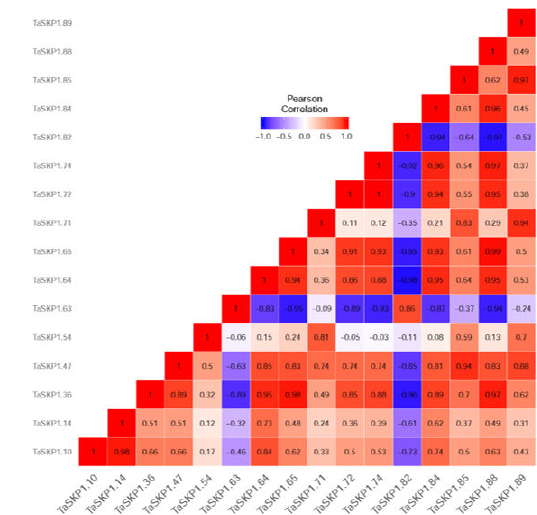
Figure 7. Pearson correlations between 16 TaSKP1 di ff erentially expressed genes under 1 h of drought, heat and a combination of drought and heat from Liu et al. [32]. Dark red color indicates a strong positive correlation. Dark blue color indicates a strong negative